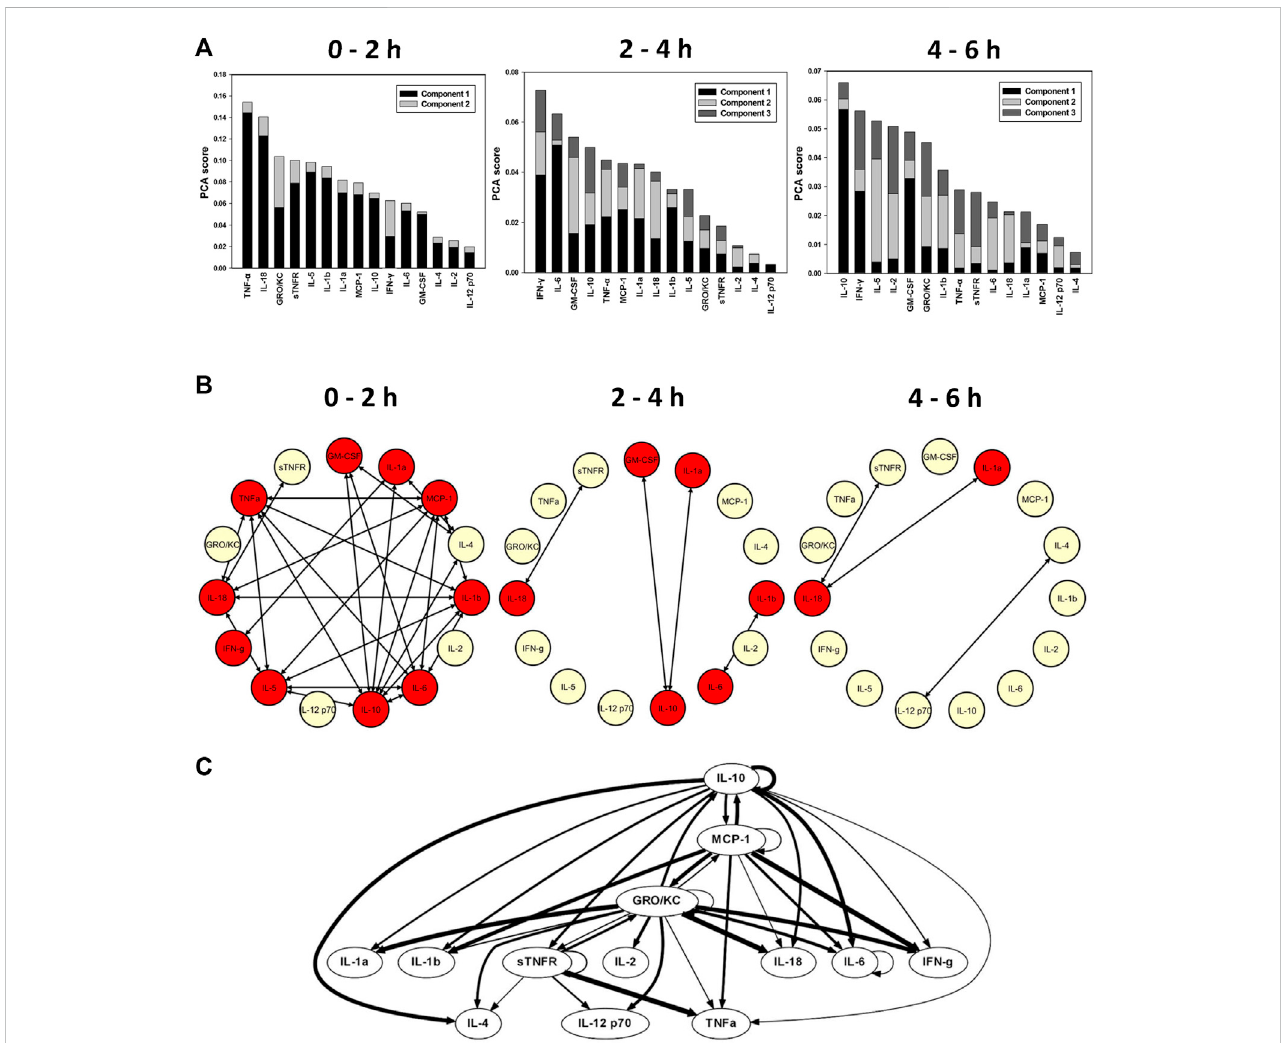
Impactofthenegativecontrolbioreactorseeded withClonenine HepG2cells onthein fl ammatoryresponse inendotoxemicrats. Rats(n=4)subjected to LPS infusion for 4 h were cannulated for a further 2 h (total of 6 h experimental time) to bioreactor that does not produce sTNFR. (A) Principal component analysis (PCA) was carried out over three time intervals (0 – 2, 2 – 4, and 4 – 6 h) using time course data of circulating in fl ammatory mediators. PCA pointed to a differential role of in fl ammatory mediators that characterizes the in fl ammatory response over the three time intervals. (B) Dynamic network analysis (DyNA) of circulating in fl ammatory mediators was performed during three time frames, 0 – 2, 2 – 4, and 4 – 6 h, as described in Materials and Methods. In fl ammatory mediators encircled with a red circle represent mediators (TNF-- α , IL--6, MCP--1, IL--2, IL--5, IL--1 α , IL--1 β , IL--10, IL--18, IFN-- γ , GM--CSF, and GRO/KC) that were statistically signi fi cantly altered by One--way ANOVA ( p < 0.05) with at least one connection to another mediator. (C) Dynamic BayesianNetwork(DyBN)inferenceofthein fl ammatorymediatorsoverthe6 hstudyperiodsuggestedthatcentralnodesconsistedoftheGRO/KC,MCP--1, IL--6, and sTNFR. The thickness of each arrow denotes the relative algorithmic con fi dence in a given interaction between